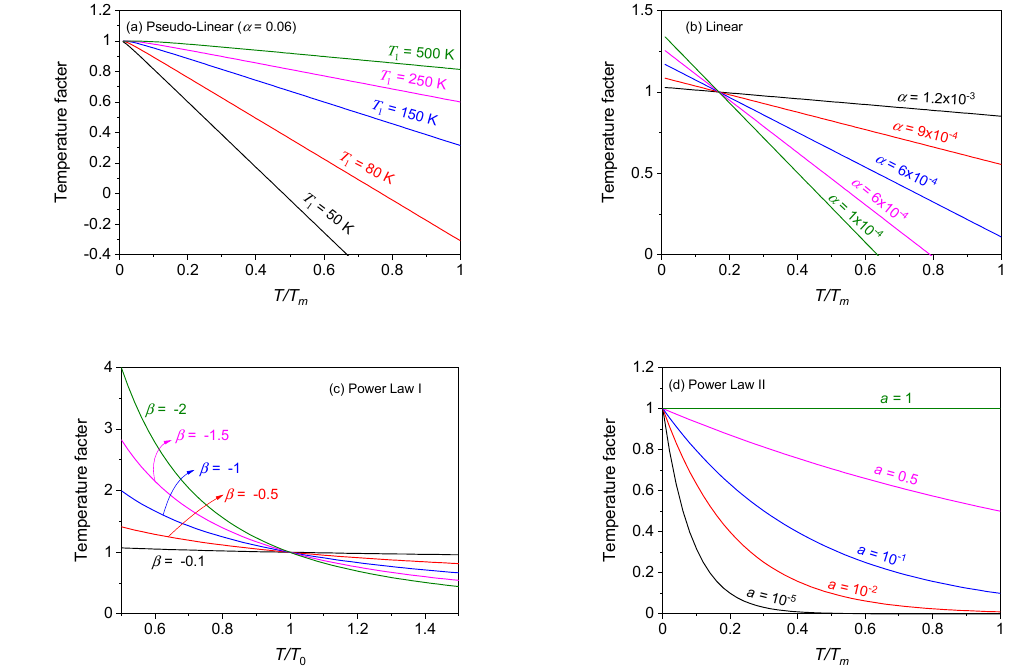
Figure 9. ( a ) Pseudo-linear; ( b ) linear; ( c ) power-law I; ( d ) power-law II TFs for different parameters ( T 0 = 298 and T m = 1783 K). These TFs did not coerce zero flow stress at the melting point.